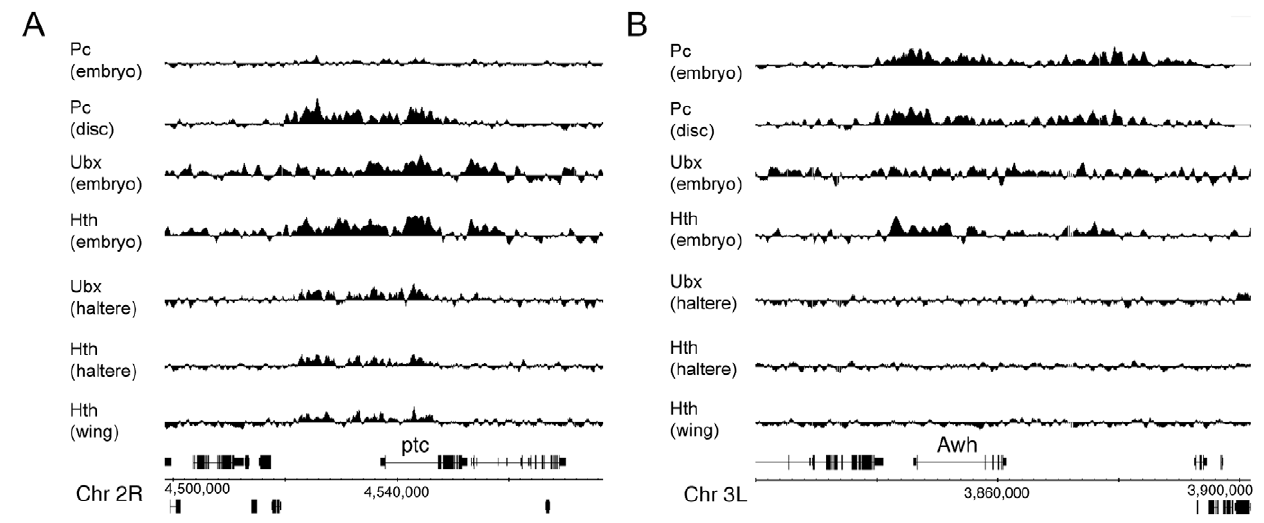
Figure 8. Ubx and Hth binding at Pc target genes. Examples of Pc target genes that are active or repressed in imaginal discs. (A) ptc is expressed in wing and haltere disc and is associated with Ubx and Hth binding. (B) Awh is likely to be predominantly silenced in imaginal discs and is bound by Ubx and Hth in the embryo but not in the imaginal discs. The Pc binding data from embryo and from T3 (haltere and leg 3) imaginal discs is from Kwong et al. [29].